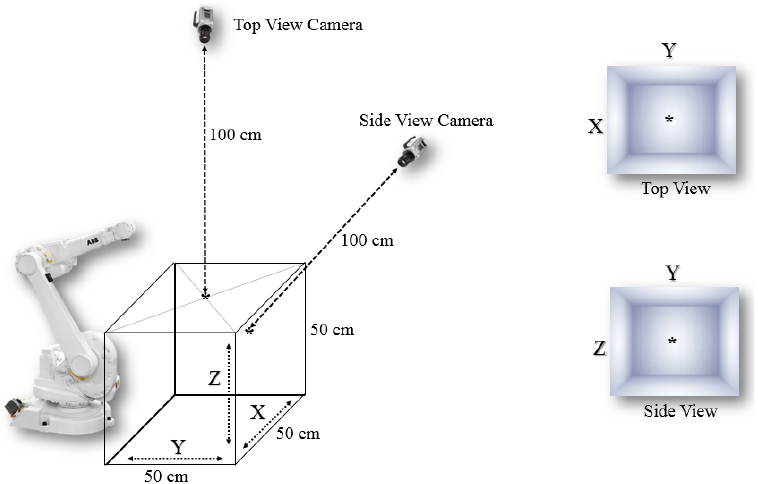
Figure 1. Workspace size and locations of cameras.